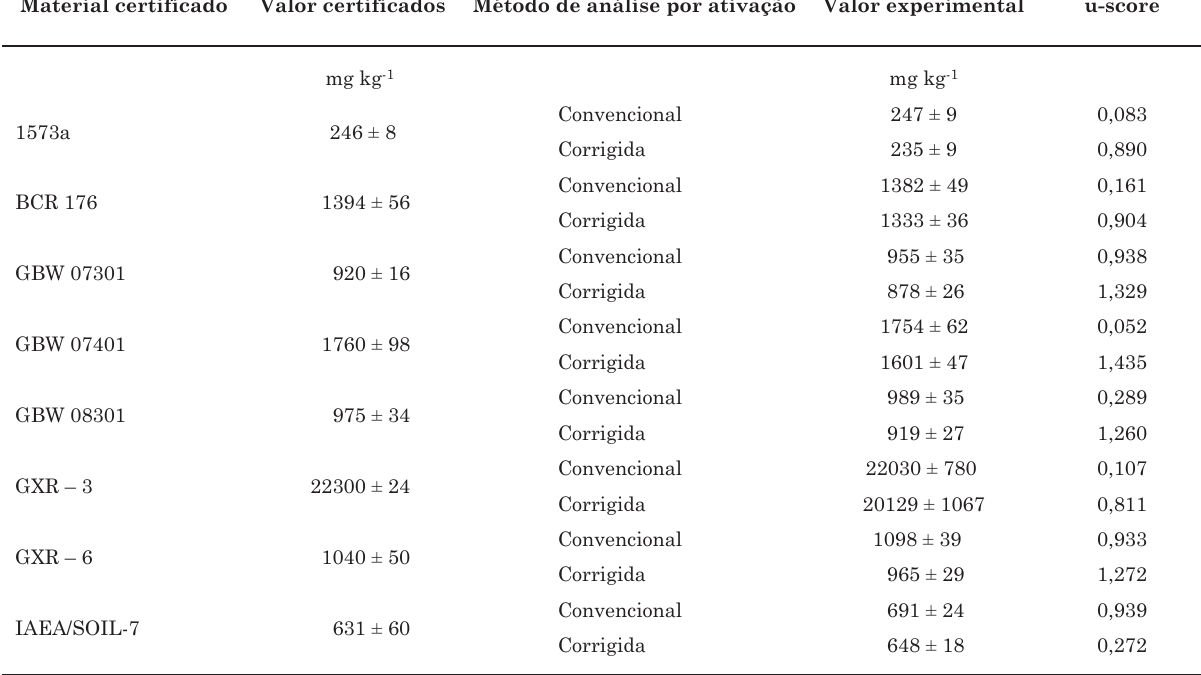
material certificado valor certificados método de análise por ativação valor experimental